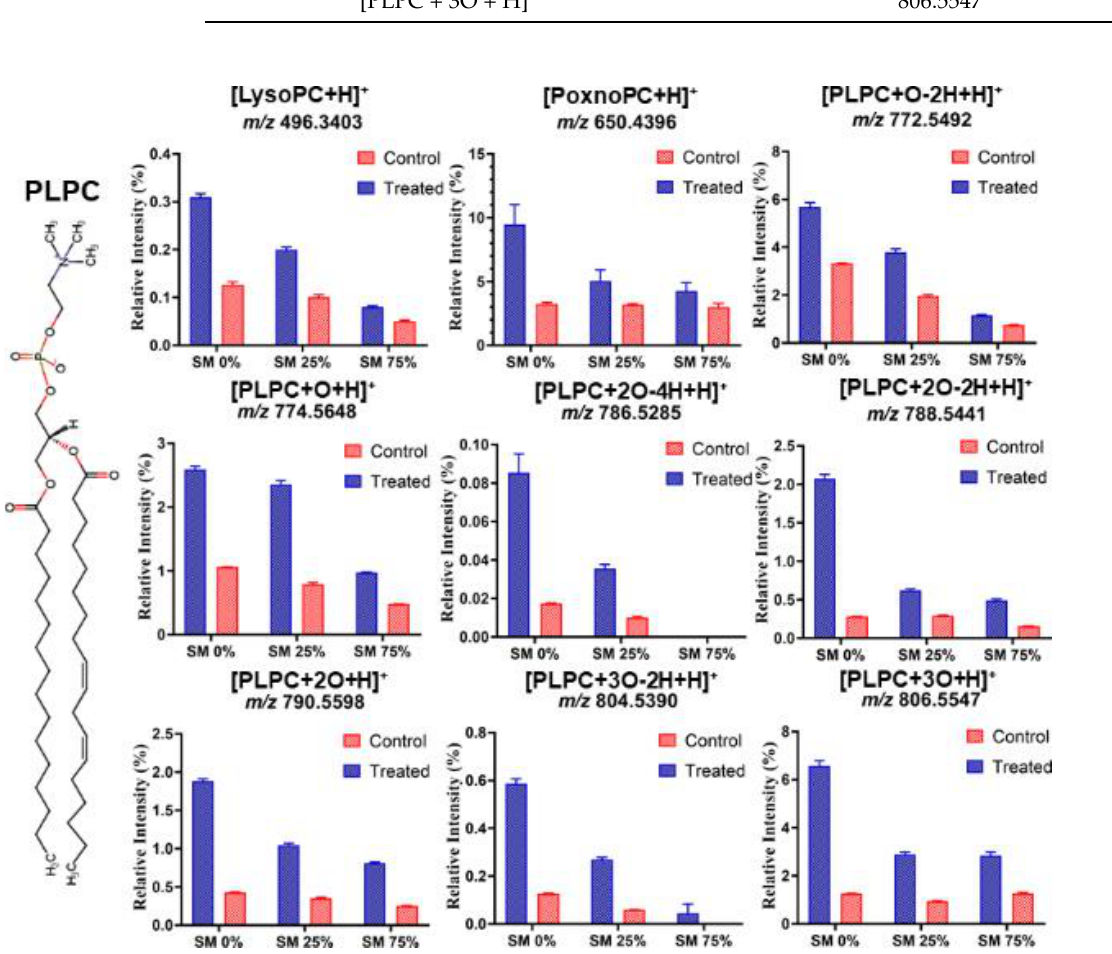
Figure 3. The relative intensity for different PLPC oxidation products obtained from lipid bilayers with different SM fraction after 30 min plasma treatment (Treated) and after auto-oxidation (Control) ( n = 3). Data were obtained by HR-mass spectroscopy. The relative intensity of each lipid peroxidation product (LPP) is calculated as the peak area of LPP divided by the peak area of unmodified PLPC in the same sample. Note that the different graphs have different scaling of the y -axis. 1-Palmitoyl-2-hydroxy-sn-glycero-3-phosphocholine and 1-palmitoyl-2-( 9′ -oxo-nonanoyl)-sn-glycero-3-phosphocholine were presented as LysoPC and PoxnoPC, respectively.